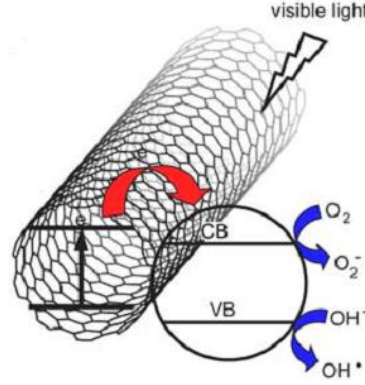
Figure 6. Proposed photocatalytic mechanism of SnO2-CNTs nanostructures. VB: Valence band; CB: conduction band.